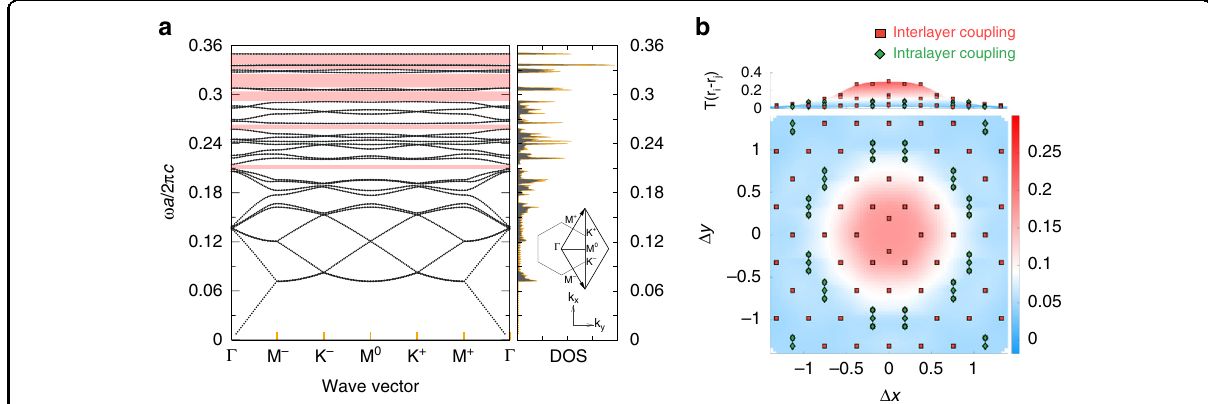
Fig. 2 Band structures and the coupling strength between quasi-atoms. a Band structure of the lowest 28 photonic energy bands. Contrary to the weak coupling regime of the moiré superlattice, we fi nd large gap openings in the high energy modes (pink regions). b Hopping strength as a function of the displacement between two different quasi-atoms along the x and y directions. We fi nd that the strength of the interlayer coupling (red squares) dominates over the intralayer coupling (green diamonds). This result directly veri fi es that our photonic crystal exhibits the strong coupling regime of the moiré